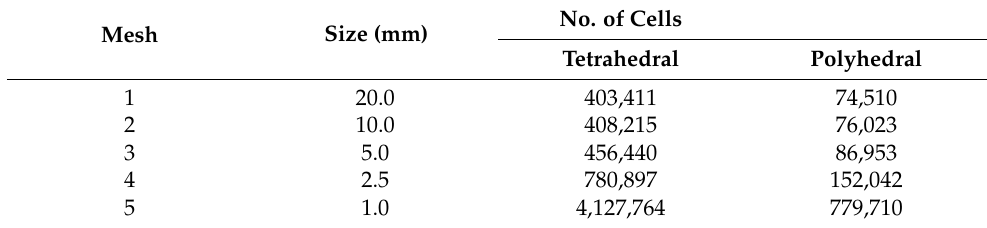
Table 1. Summary of meshing qualities for the sensitivity analysis.